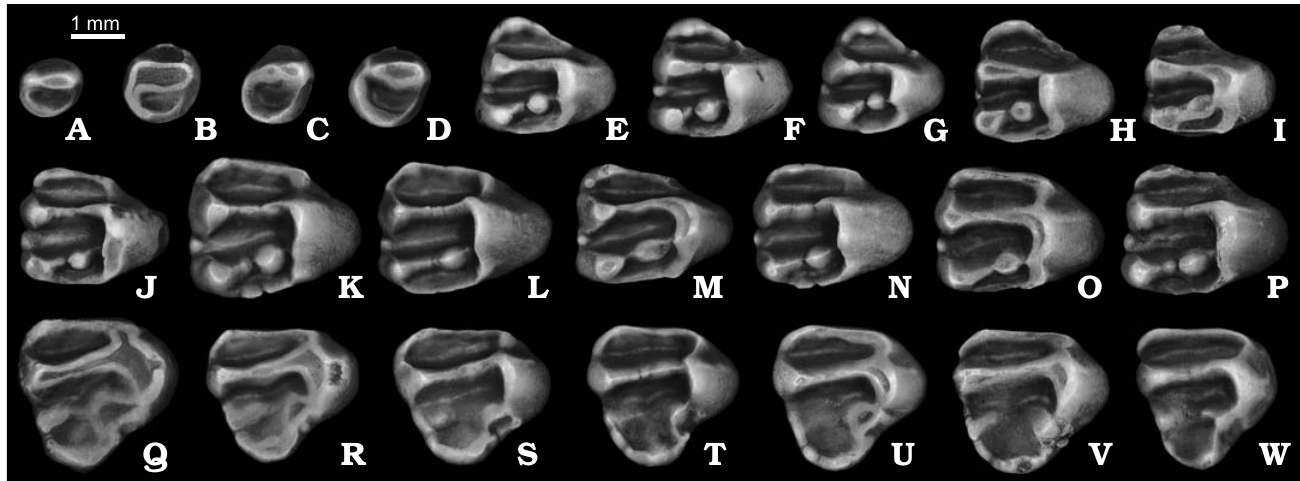
Fig. 6. Ground squirrel Spermophilus praecox sp. nov. from the late Pliocene and Early Pleistocene of southern Ukraine: Kryzhanovka 2 (A, J), Kotlovina 2 (E, F, K, L, Q, R), Kotlovina 3 (G, M, S), Yuzhny (B, N, T, U), Morskoy (C, D, H, I, V, W); upper cheek teeth (A–D, P3; E–I, P4; J–P, M1–M2; Q–W, M3), in occlusal views. A . ZIN 105160/1. B . GIN 1166/1. C . NMNHU-P MoT-2. D . NMNHU-P MoT-4. E . NMNHU-P 41-5588. F . NMNHU-P 41-5589. G . NMNHU-P 41-5611. H . NMNHU-P MoT-6. I . NMNHU-P MoT-10. J . ZIN 105160/5. K . NMNHU-P 41-5598 (holotype). L . NMNHU-P 41-5599. M . NMNHU-P 41-5613. N . GIN 1166/4. O . NMNHU-P MoT-14. P . NMNHU-P MoT-16. Q . NMNHU-P 41-5601. R . NMNHU-P 41-5602. S . NMNHU-P 41-5616. T . GIN 1166/11. U . GIN 1166/12. V . NMNHU-P MoT-31. W . NMNHU-P MoT-32. C, J, K, O, Q, S